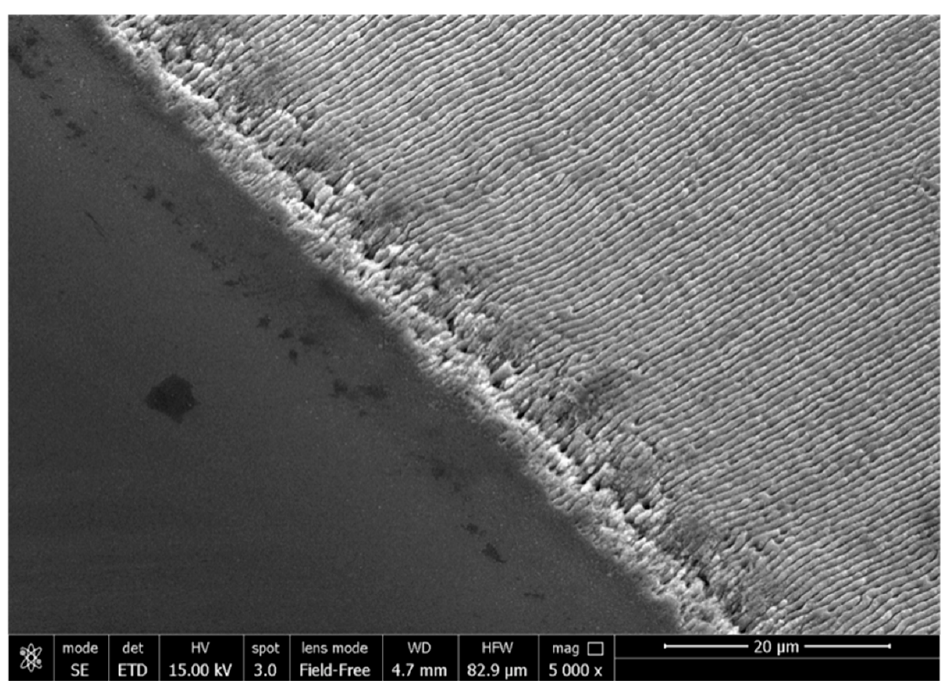
Figure 2. SEM image of flat (left) and HR-LIPSS generated on Si surface. Following the Au NPs deposition protocol (Figure 1), the Au NPs were successfully attached to the surfaces, as confirmed by SEM imaging. Using the protocol of droplet evaporation after surface functionalization, a plethora of Au NPs with various shapes and sizes, including spheres and rods, were successfully deposited (Figure 3). Thus, sphere-shaped Au NPs with 13 nm diameter (Figure 3a,b), sphere-shaped Au NPs with 80 nm diameter (Figure 3c,d), and rod-shaped Au NPs with 53 nm length, aspect ratio 3:1 (Figure 3e,f), were chemically attached to both flat and nanopatterned Si substrates. Remarkably, the Au NPs could conformably disperse over the entire surface area of the nanostructured substrates, covering both the “ripples” (Figure 3b,d,f) and the surrounding flat area (Figure 3a,c,e). Au NPs were in the form of single particles but also in the form of small clusters (Figure 3c). Finally, to improve the sphere-shaped Au NPs’ (13 nm diameter) dispersion onto the functionalized surfaces, Au NPs solution was diluted in ethanol before the drop evaporation step. Elemental analysis with energy-dispersive X-ray spectroscopy (EDS) of the nanopat- terned Si substrates showed that, apart from the Si peak (Figure 4b), carbon (C) and Oxygen (O) elements are observed in respect to untreated Si, where we observed the only peak of Si (Figure